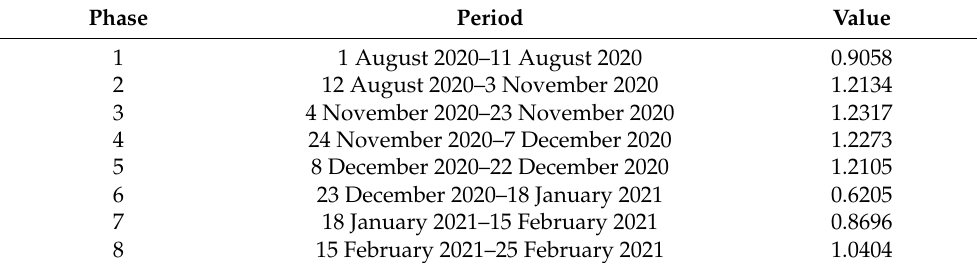
Figure 5. The parameter estimation results. Red squares and dark curves denote the real data and model simulation results using data-fitted parameters, respectively. ( A ) reproductive number, ( B ) daily incidence, and ( C ) cumulative incidence. Table 2. The data-fitted phase-dependently adjusted constant ( β 0 ( t ) ).